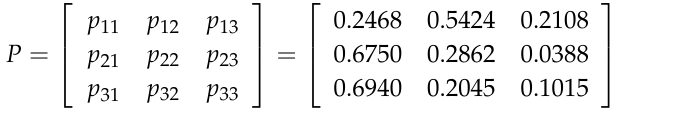
Table 1. The proportion of tour types; H-H: from the residential area to the residential area; H-O: from